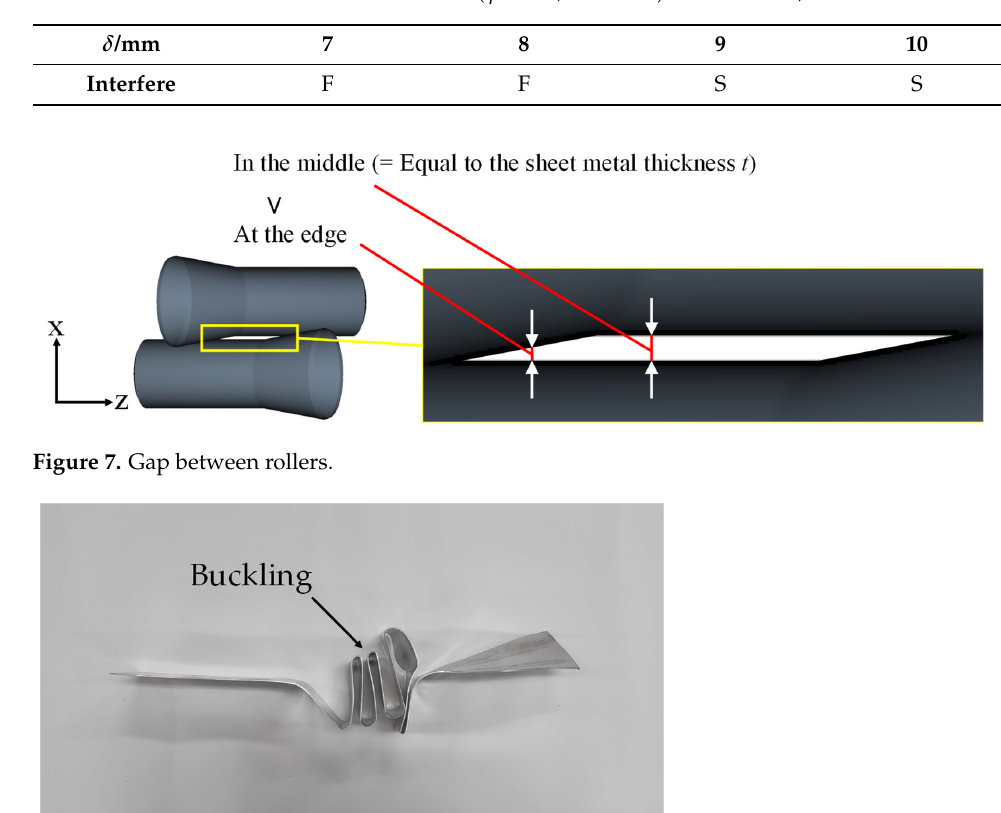
Figure 8. Buckling of formed product in the experiment ( δ = 9 mm).